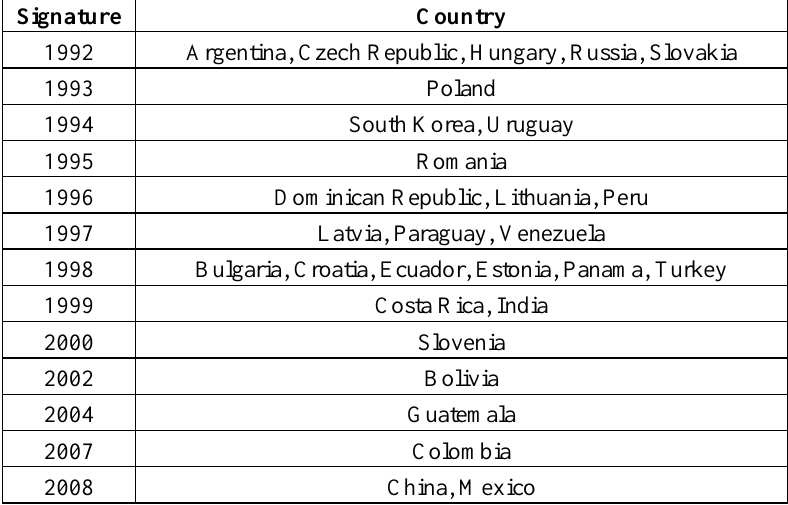
Table A3 : Spanish Bilateral Investment Treaties: